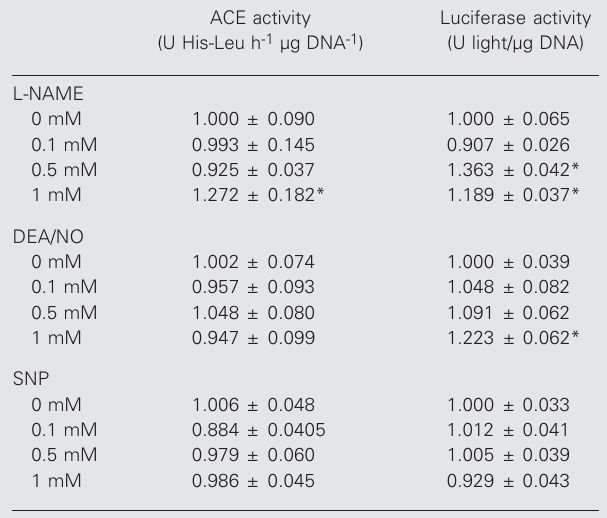
Table 1. Angiotensin-I converting enzyme (ACE) and luciferase activity of WLuc cells treated with L-NAME, DEA/NO and SNP for 18